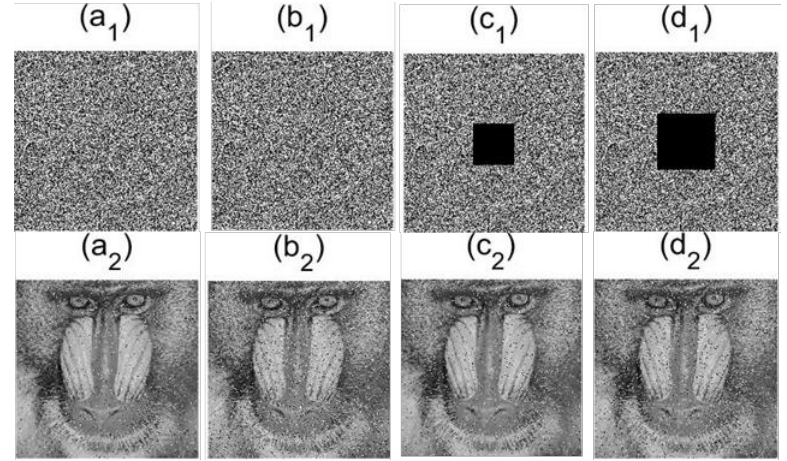
Figure 22. Robustness analysis ( a 1 ) 1% speckle noise (encrypted); ( a 2 ) 1% speckle noise (decrypted); ( b 1 ) 3% speckle noise (encrypted); ( b 2 ) 3% speckle noise (decrypted); ( c 1 ) 5% data loss